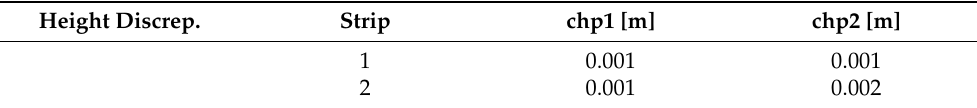
Table 5. Height discrepancies of check points between strips of synthetic data. Height